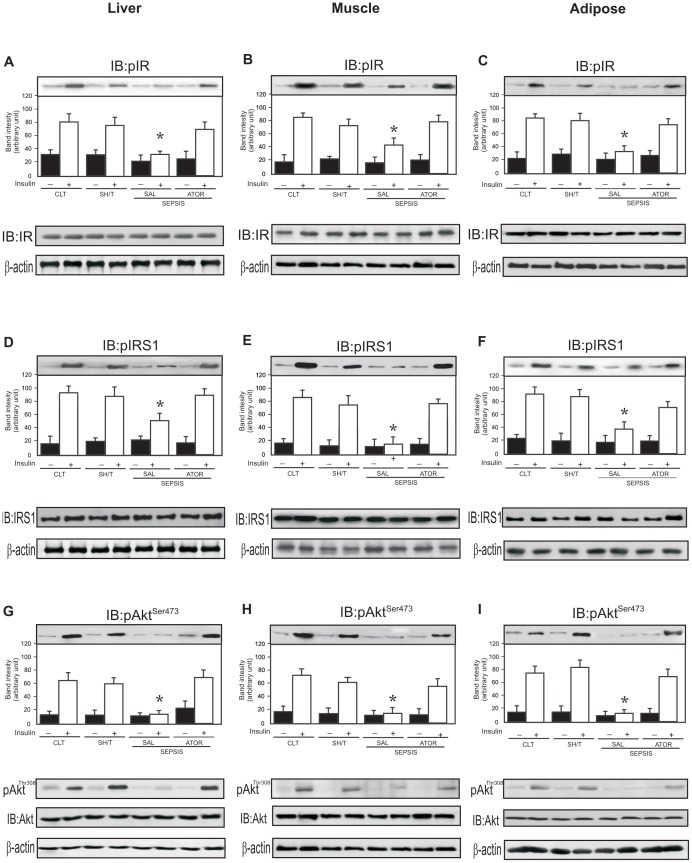
Effects of atorvastatin treatment on insulin signaling in the CLP rat.Representative blots show insulin-induced tyrosine phosphorylation of Insulin Receptor β (IRβ) in liver (A), muscle (B) and adipose (C) of sham and septic rats. Total protein expression of IRβ (A–C, lower panels). Insulin-induced tyrosine phosphorylation of Insulin Receptor Substrate 1 (IRS1) in liver (D), muscle (E) and adipose tissue (F) of sham and septic rats. Total protein expression of IRS1 (D–F, lower panels). Insulin-induced serine phosphorylation of Akt in liver (G), muscle (H) and adipose (I) of sham and septic rats. Insulin-induced threonine phosphorylation and total protein expression of Akt (G–I, lower panels). In this case, blots were stripped and reprobed with β-actin (A–I, lower panels) to confirm equal loading of proteins. Data are presented as means +/− S.E.M from 6–8 rats per group. *P<0.05 (Sepsis/Sal vs. all others groups). IB, immunoblot; CLT: Sham/Saline; ShT: Sham/Atorvastatin; SAL: saline; ATOR: atorvastatin.